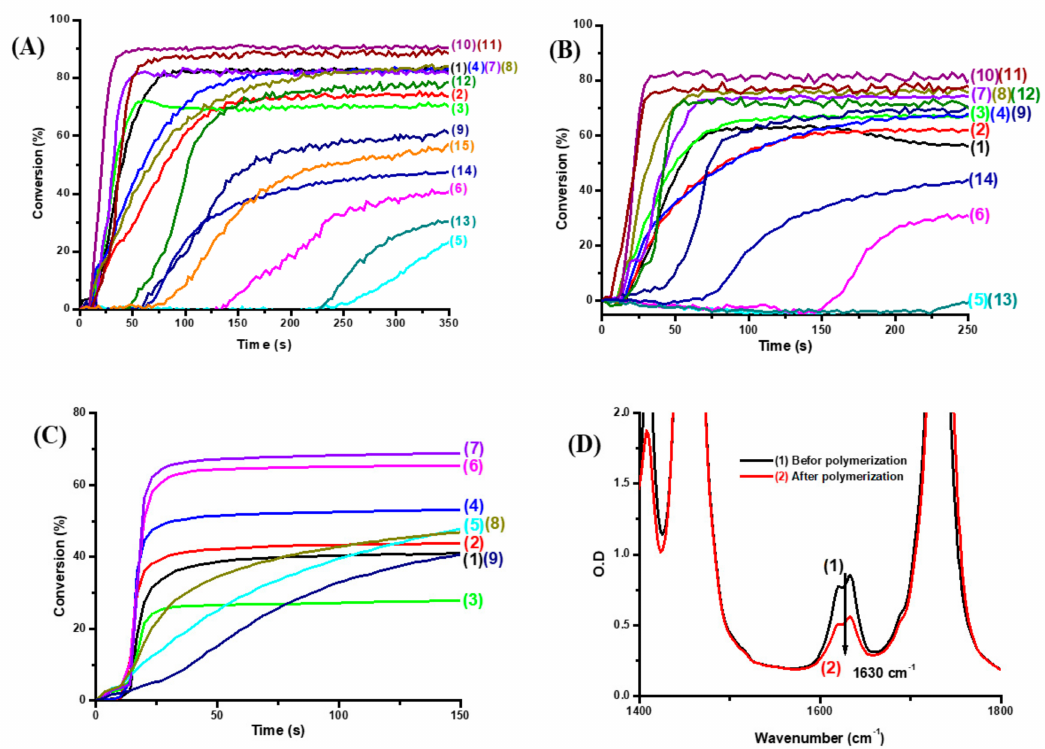
Figure 1. Polymerization profiles (acrylate function conversion vs. irradiation time) for TA ( A ) and TMPTA ( B ) (thickness = 1.4 mm in laminate) upon exposure to the LED @ 405 nm in the presence of the two- and three-component photoinitiating systems: (1) Coum 1 / Iod (0.05% / 1% w / w ), (2) Coum 1 / Iod (0.1% / 1% w / w ), (3) Coum 2 / Iod (0.05% / 1% w / w ), (4) Coum 2 / Iod (0.1% / 1% w / w ), (5) Coum 3 / Iod(0.05% / 1% w / w ), (6) Coum 3 / Iod (0.1% / 1% w / w ), (7) Coum 1 / Iod / EDB (0.05% / 1% / 1% w / w / w ), (8) Coum 2 / Iod / EDB (0.05% / 1% / 1% w / w / w ), (9) Coum 3 / Iod / EDB (0.05% / 1% / 1% w / w / w ), (10) Coum 1 / Iod / NPG (0.05% / 1% / 1% w / w / w ), (11) Coum2 / Iod / NPG (0.05% / 1% / 1% w / w / w ), (12) Coum3 / Iod / NPG (0.05% / 1% / 1% w / w / w ), (13) Iod / EDB (1% / 1% w / w ), (14) Iod / NPG (1% / 1% w / w ) and (15) Coum3 / Iod (0.05% / 1% w / w ) with 5 drops of chloroform. ( C ) Polymerization profiles (acrylate function conversion vs. irradiation time) for TMPTA (thickness = 25 µ m in laminate) upon exposure to the LED @ 405 nm in the presence of two- and three-component photoinitiating systems: (1) Coum 1 / Iod (0.05% / 1% w / w ), (2) Coum 1 / Iod (0.1% / 1% w / w ), (3) Coum 2 / Iod (0.05% / 1% w / w ), (4) Coum 2 / Iod (0.1% / 1% w / w ), (5) Coum 3 / Iod (0.1% / 1% w / w ), (6) Coum 1 / Iod / NPG (0.1% / 1% / 1% w / w / w ), (7) Coum 2 / Iod / NPG (0.1% / 1% / 1% w / w / w ), (8) Coum 3 / Iod / NPG (0.1% / 1% / 1% w / w / w ) and (9) Iod / NPG (1% / 1% w / w ). ( D ): IR spectra obtained before and after polymerization for Coum 1 / Iod / NPG (0.05% / 1% / 1% w / w / w ) in TMPTA (thickness = 25 µ